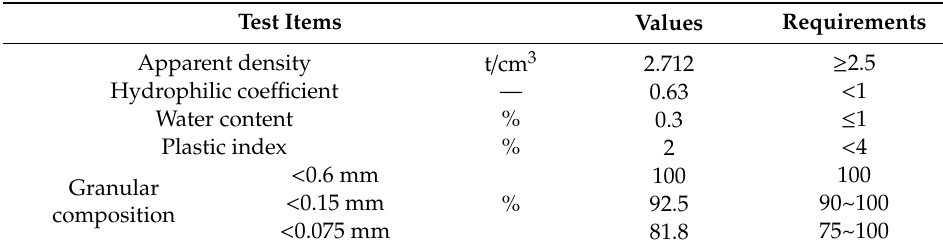
Table 4. Technical properties of limestone mineral filler.